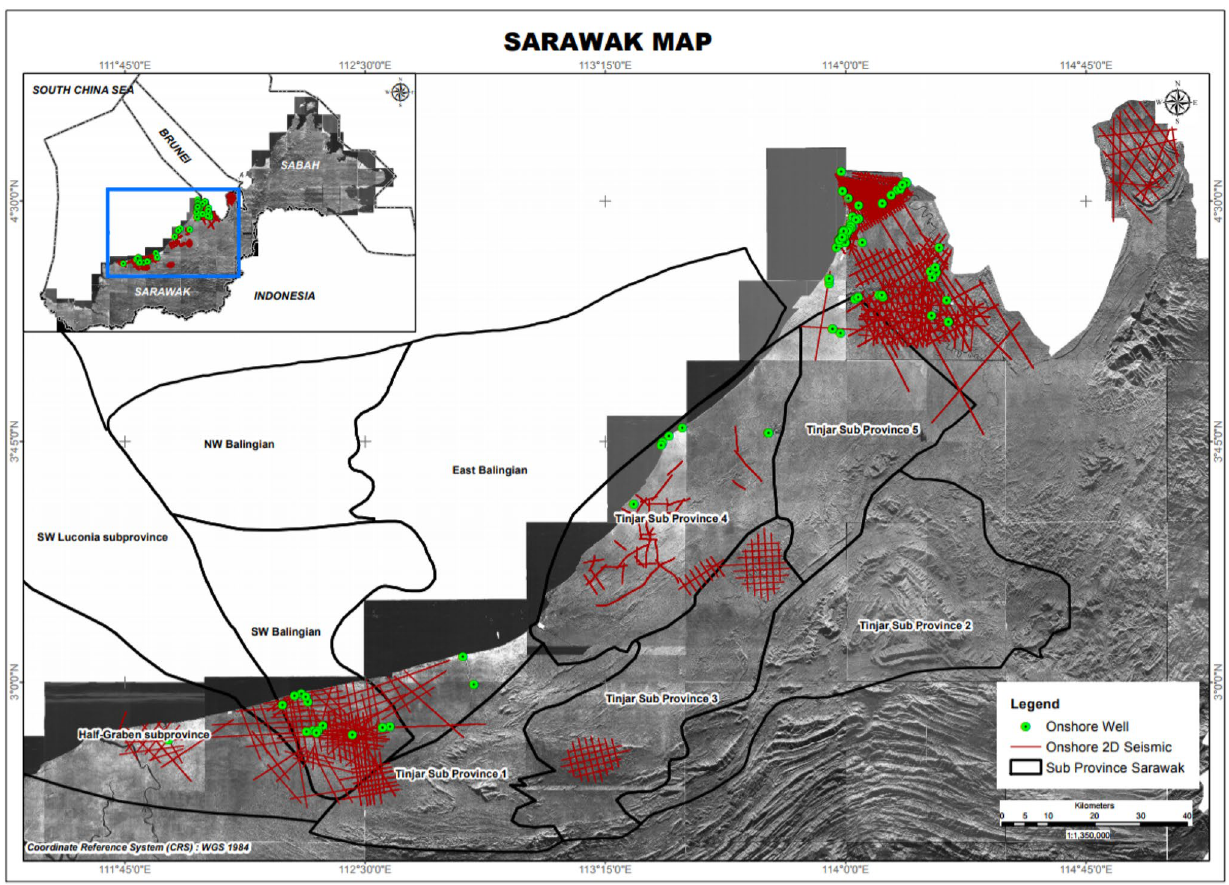
Fig. 6 Overview of seismic lines and well locations in Sarawak onshore. Observe the high density of drilled wells and acquired seismic sections in the Onshore Baram